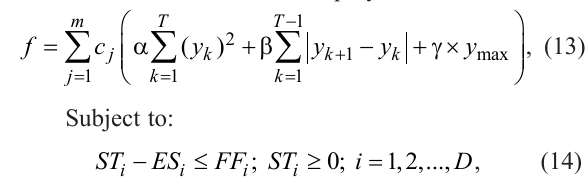
Fig. 4. Flowchart of FCDE for RL problem (FCDE-RL)